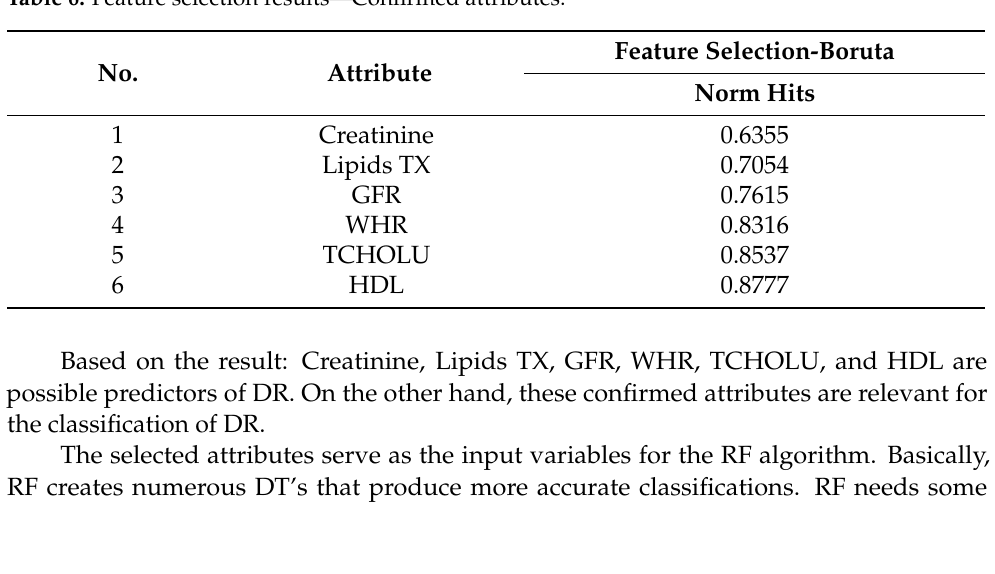
Table 6. Feature selection results—Confirmed